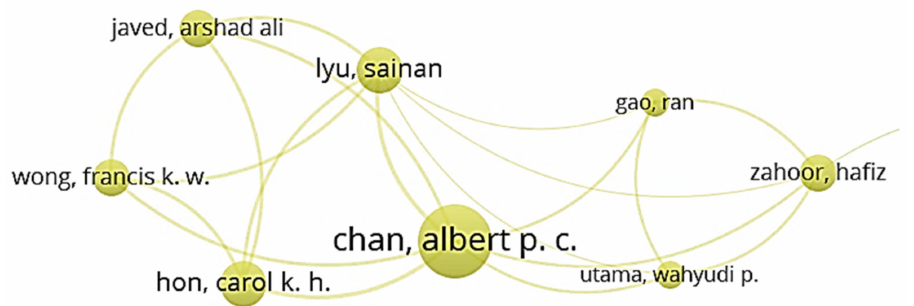
Figure 2. Co-authorship network of cluster